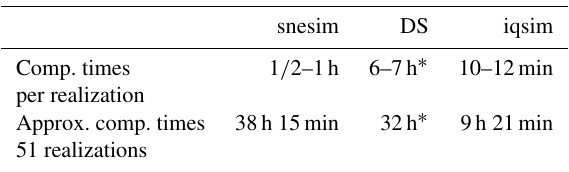
Table 2. A table presenting the average computation times per re- alization for each of the three MPS methods and the approximated computation times needed for running 51 realizations with the setup used in this study. ∗ indicates that the given realizations were run in parallel on a server; other realizations were generated on a personal laptop. snesim DS iqsim Comp. times per realization Approx. comp. times